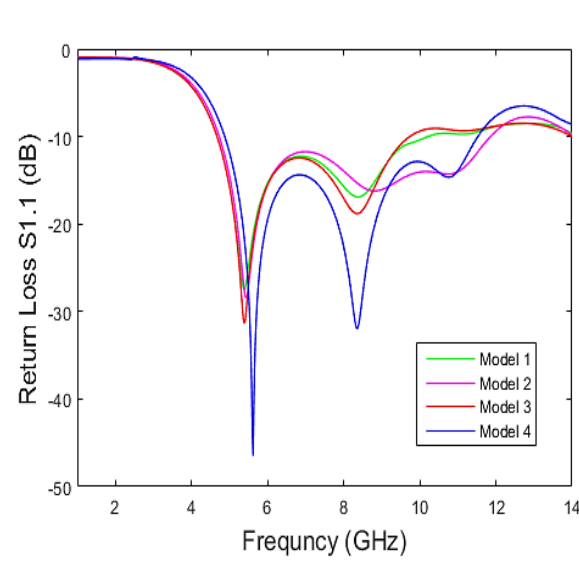
Figure 5: Simulated return loss S1.1 for various iterations number